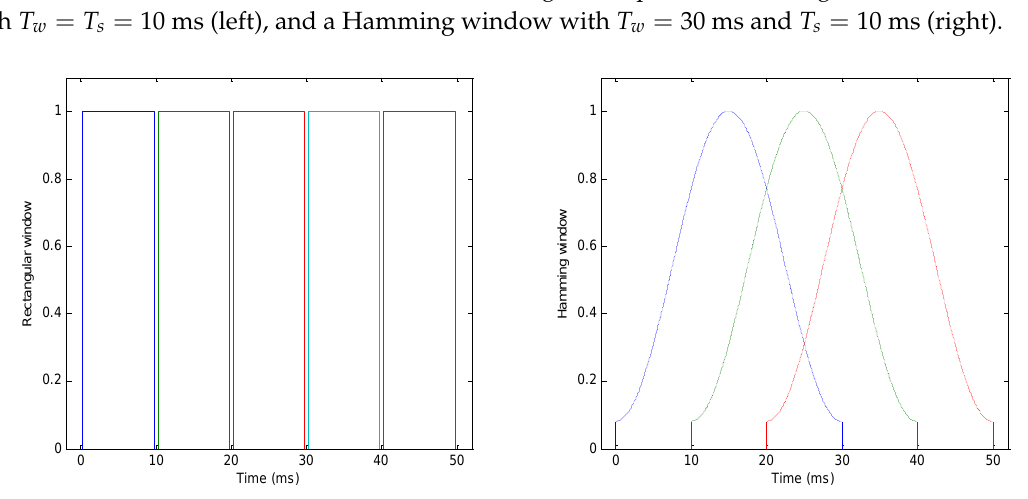
Figure 5. Sound framing in the time domain: ( left ) rectangular window function; ( right ) Hamming window function.